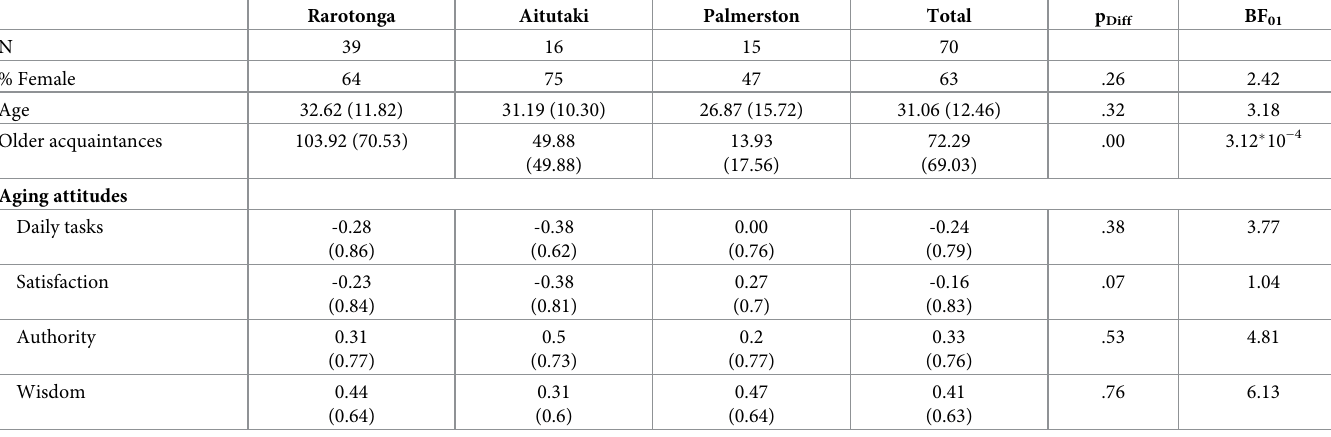
Table 1. Sample characteristics and aging attitudes by